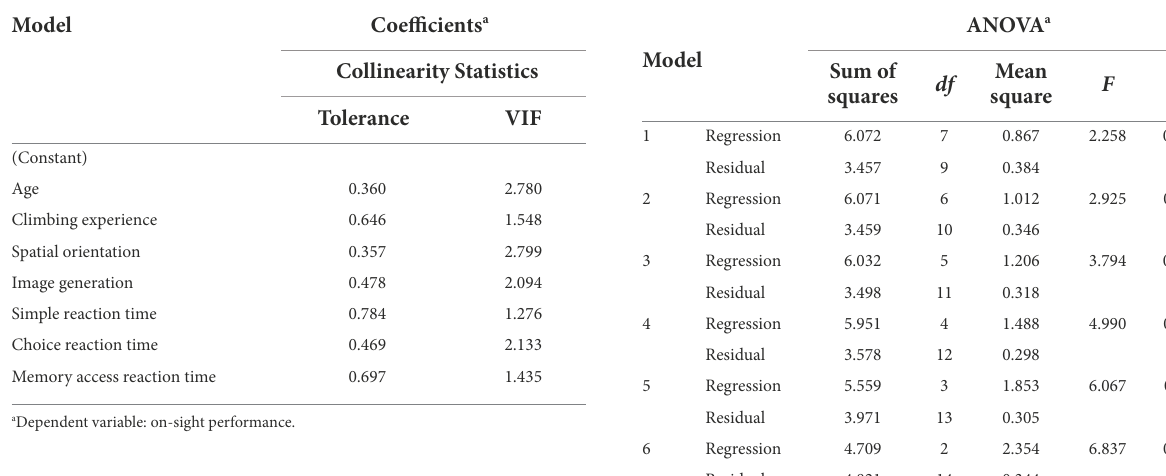
TABLE 5 VIF values for red-point performance.